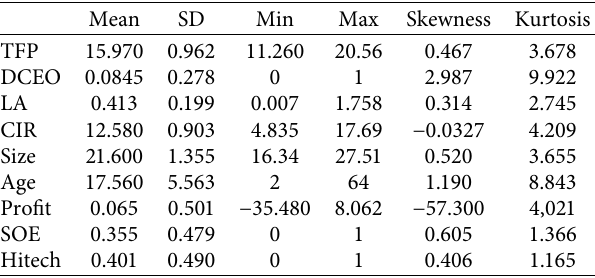
Table 1: Descriptive statistics of variables. Table 2: Balance test of variables before and after